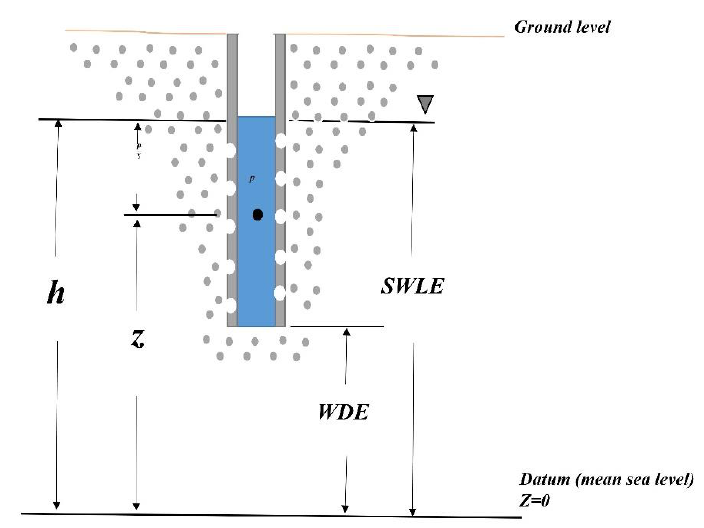
Figure 3. Representation of the hydraulic head h measured at point P within a